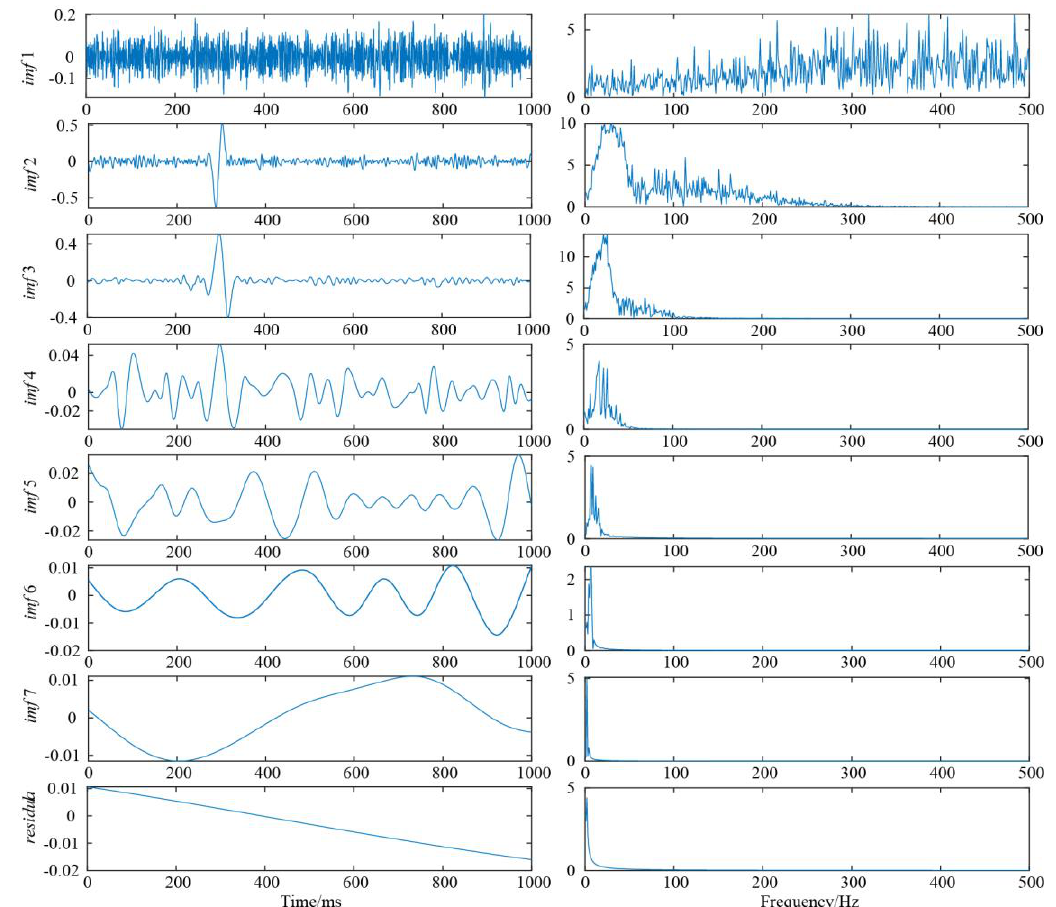
Figure 5. EMD decomposed the results of the noise Ricker waveform and the IMF’s corresponding spectrum.